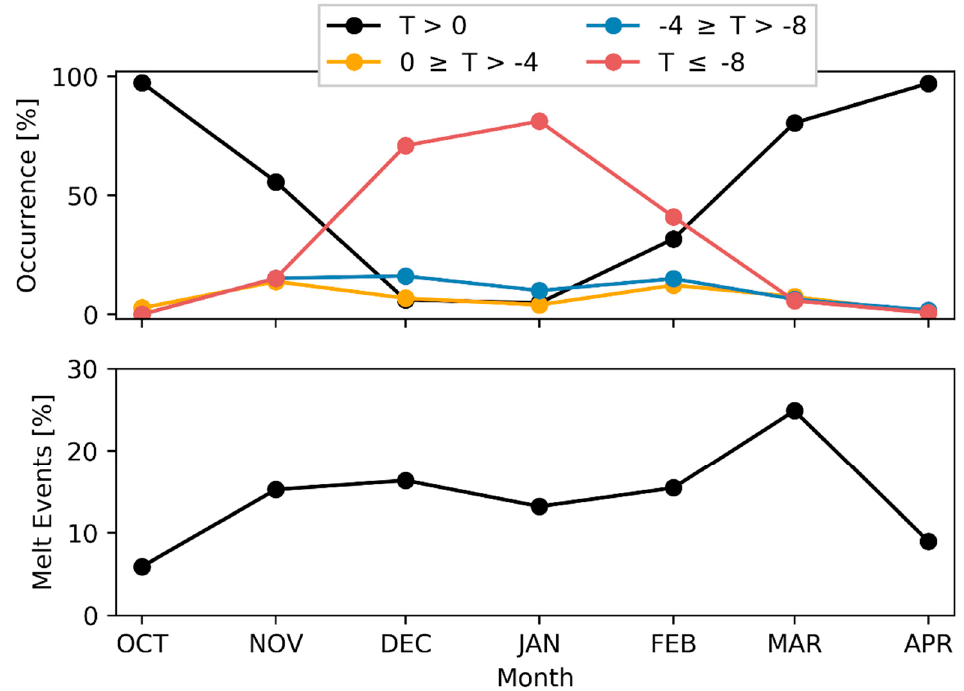
Figure 6. The percentage occurrence of GRP-detected melt events and coincident daily maximum air temperature are sorted by months across each WMO weather station ( top ). The monthly distribution of melt events detected at the WMO weather stations ( bottom ).